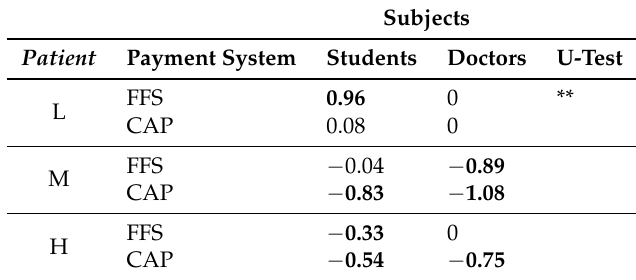
Table 10. Deviation from optimal treatment between student and medical doctor